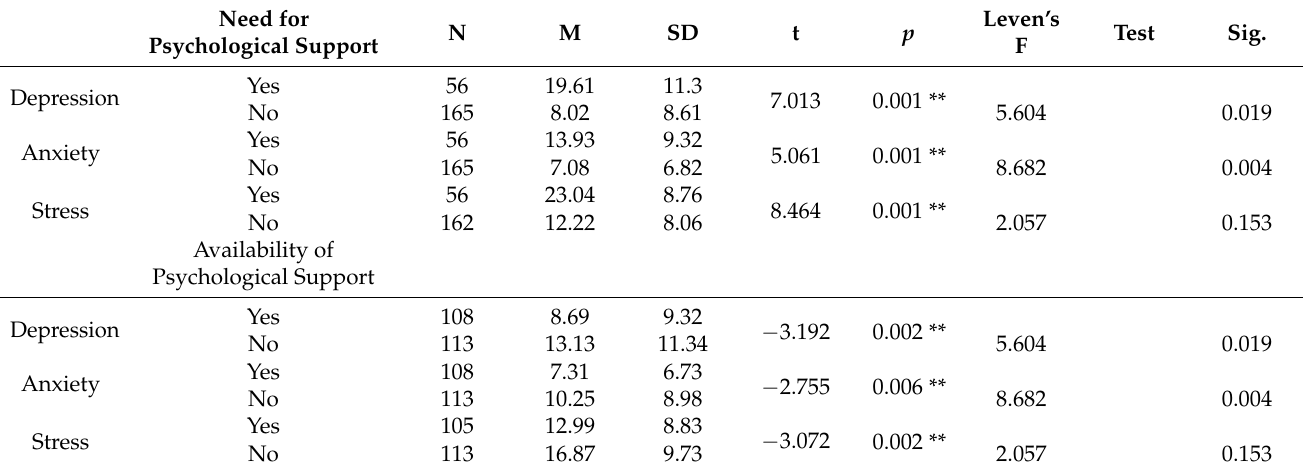
Table 9. Comparison between two groups of respondents (there is and there isn’t need for psycholog- ical support) and the ones with the available psychological support and the ones without it in respect of average values (scores) on the DASS-21